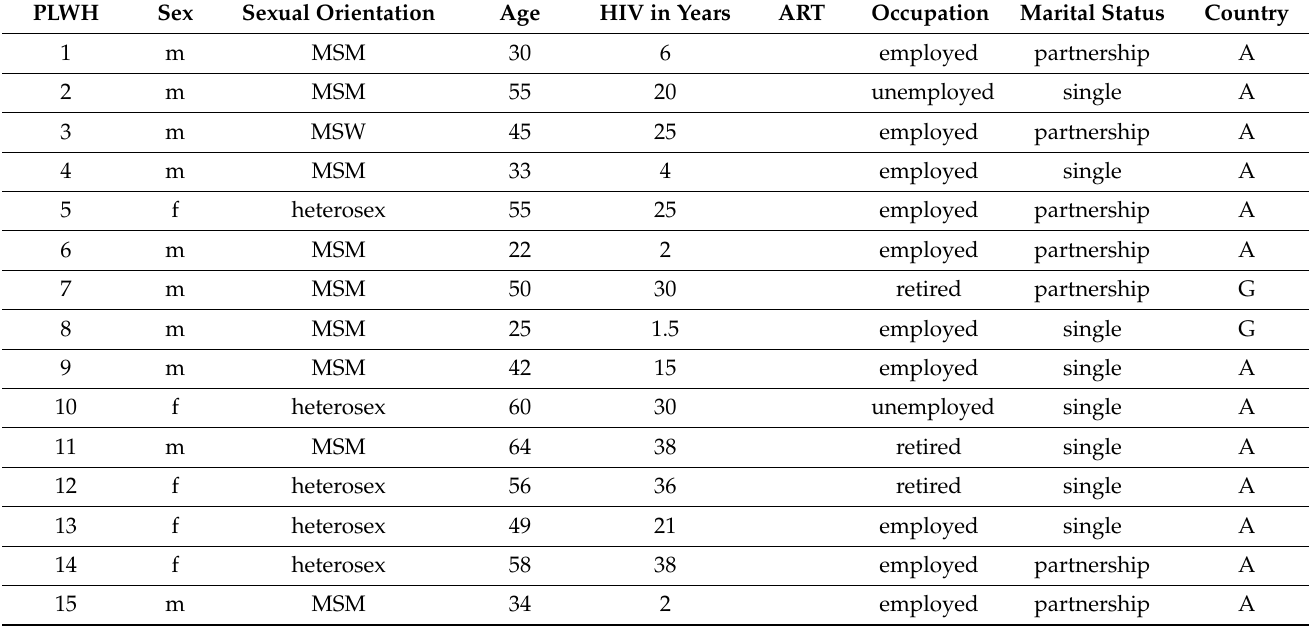
Table 2. Demographic and Life Context Description of Women and Men (N =